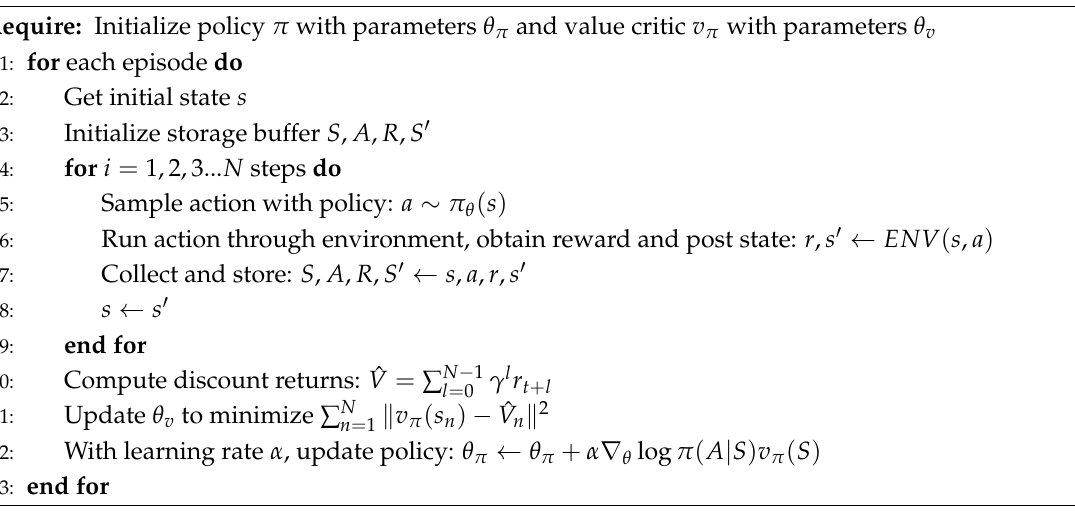
Algorithm 1 Monte Carlo on policy